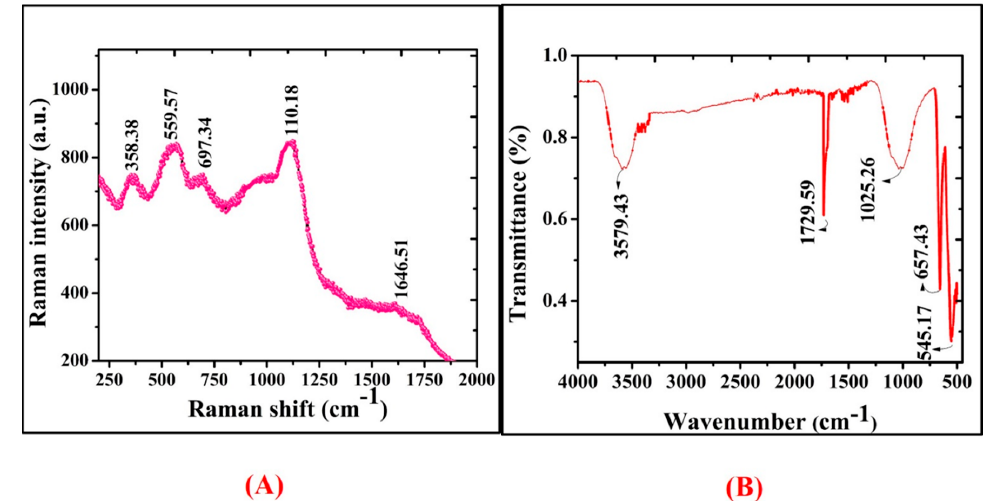
Figure 4. ( A ) Raman spectra of NiONPs ( B ) FT-IR spectra of biogenic NiONPs.